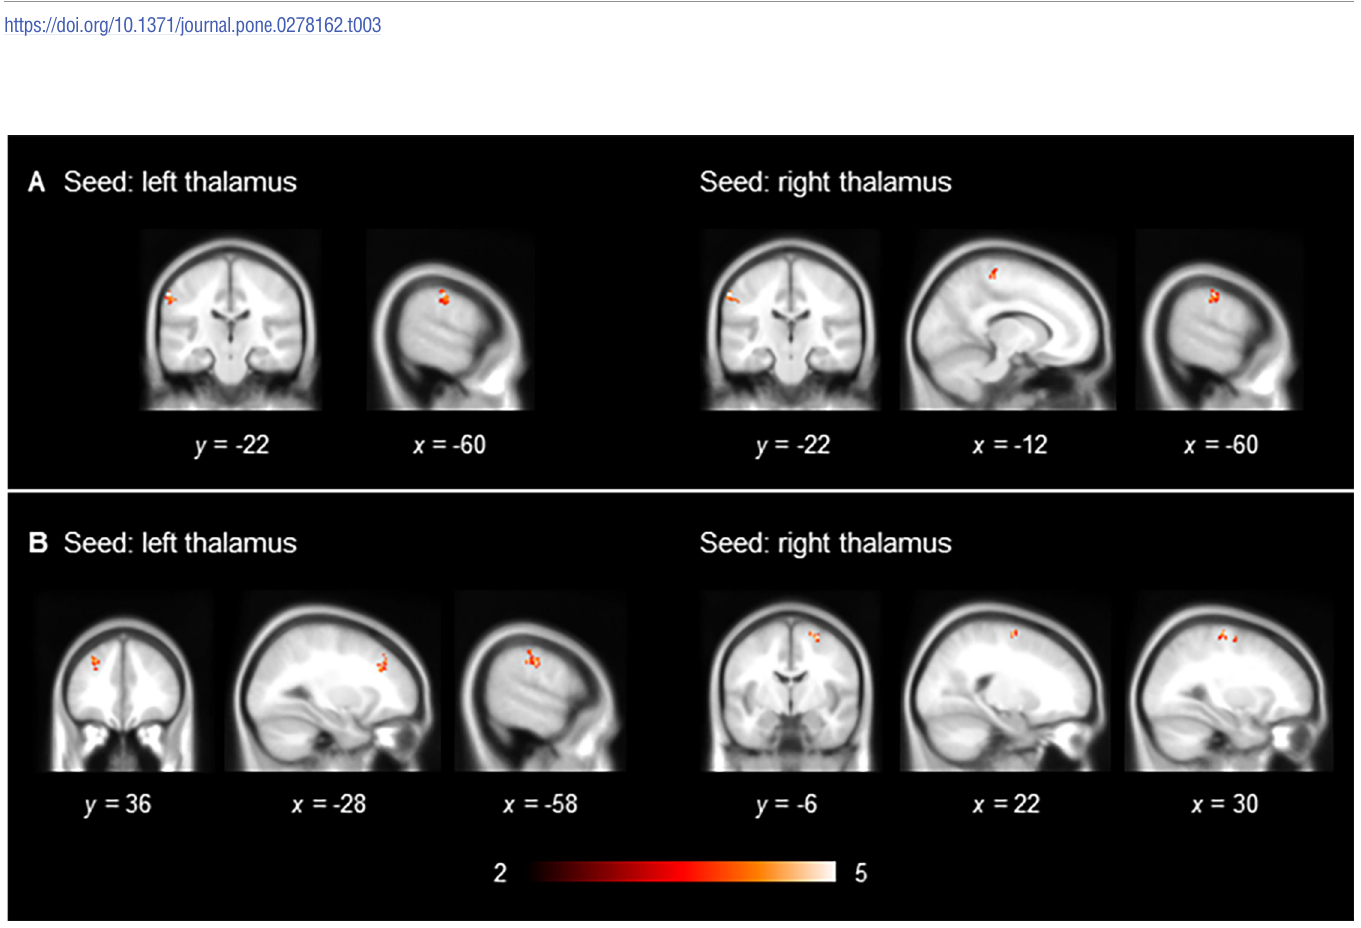
0.000 ADHD, attention-deficit/hyperactivity disorder; LNCG, local normative comparison group; GSR, global signal regression; K E , cluster extent in voxels. Positive and negative x coordinates indicate right and left hemispheres, respectively. Results are displayed at a family-wise error-corrected cluster-defining threshold of p < 0.025. A p-value < 0.00625 survives an additional Bonferroni correction for the number of preprocessing pipelines (0.025/4).